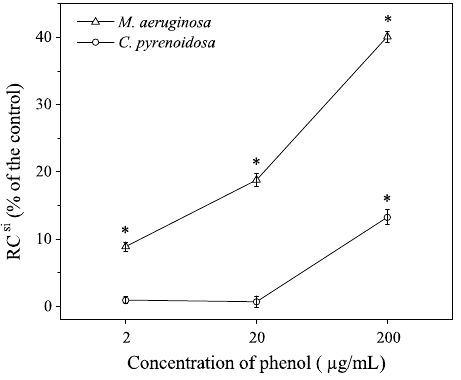
Figure 3. Percentage of the silent reaction center (RC si ) at di ff erent concentrations of phenol in mono-cultures Significant di ff erence compared with the control is indicated as * ( p <